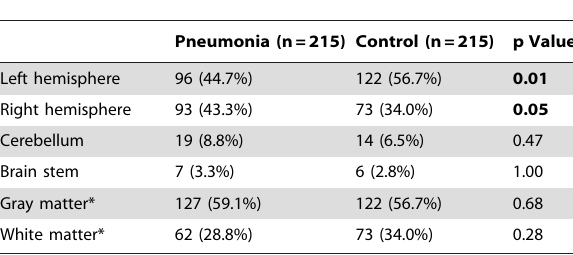
Table 2. Predominant infarct location in HAP patients and controls.